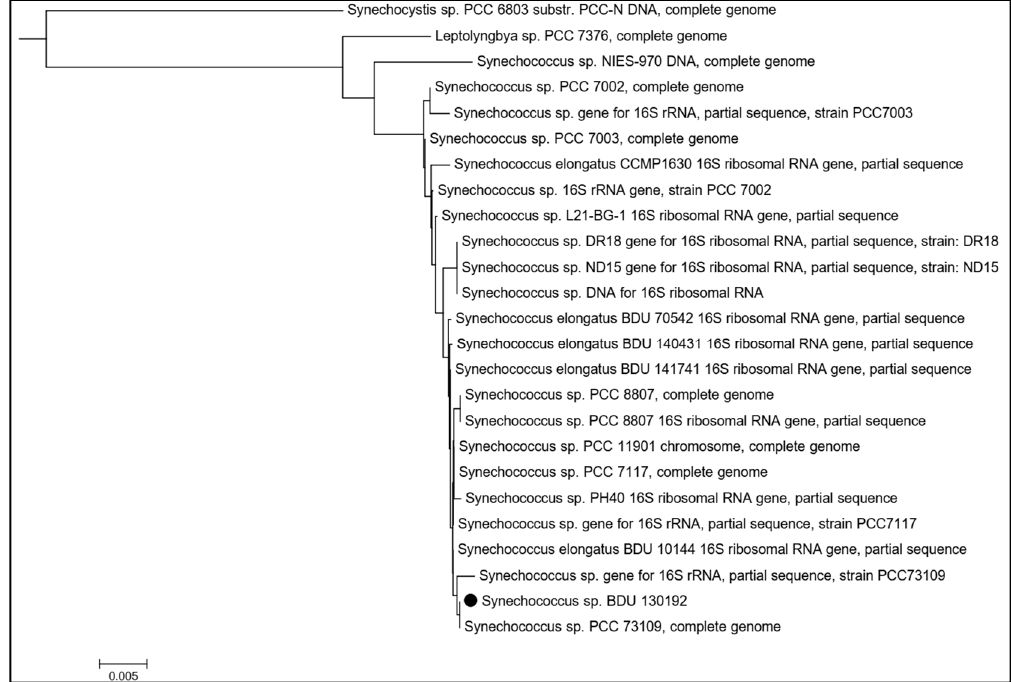
Figure 4. Phylogenetic positioning of Synechococcus sp. BDU 130192 based on NCBI database.